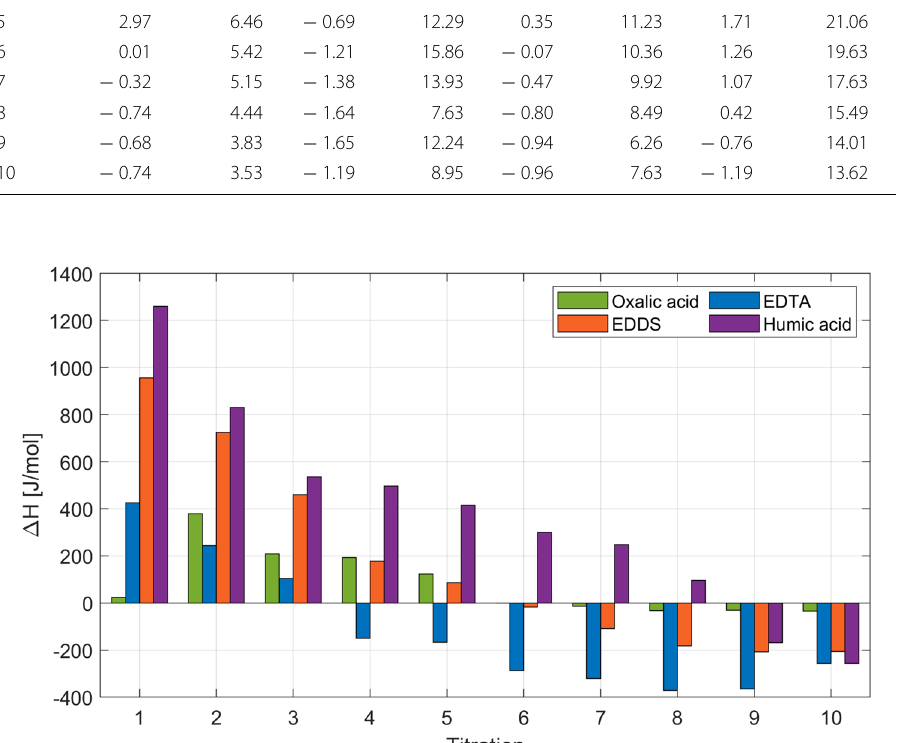
Fig. 7 Enthalpy change ( (cid:31) H ) values for 2D * TB chelating into Berea